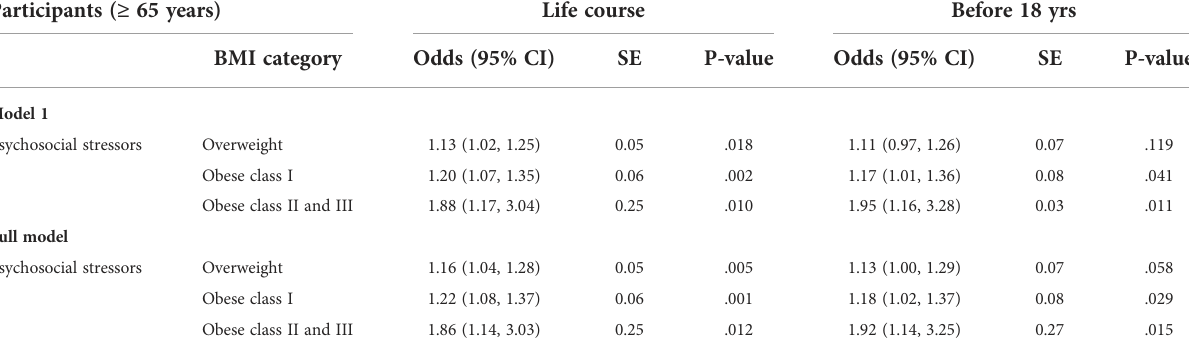
TABLE 4 Odds of BMI category considering psychosocial stressors over life course and in childhood/adolescence* adjusted for symptoms of anxiety and depression (elderly).